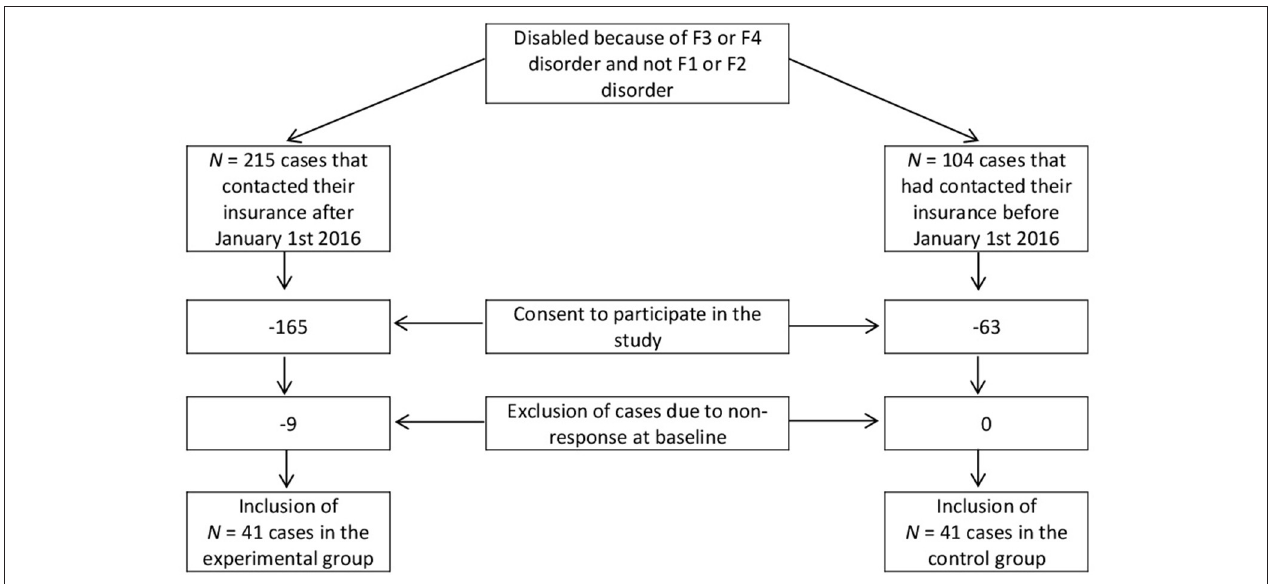
FIGURE 1 | Sampling strategy.